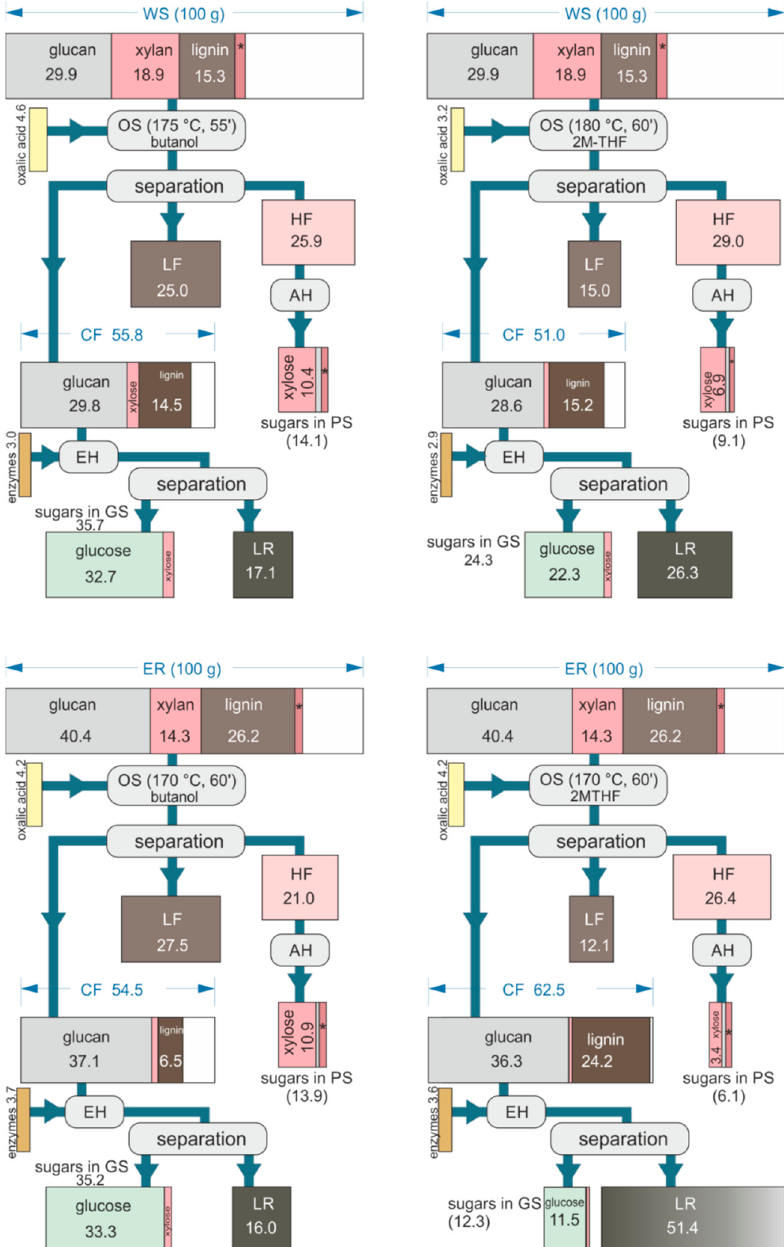
Figure 7. Fractionation at optimized pretreatment conditions of Table 5 and monomers production by EH (glucose) and AH (xylose). From top left, clockwise: WS/butanol; WS/2M-THF; ER/2M-THF,